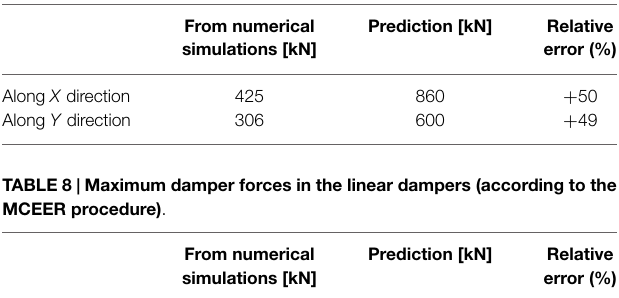
TABLE 7 | Maximum damper forces in the linear dampers (direct five-step procedure) .